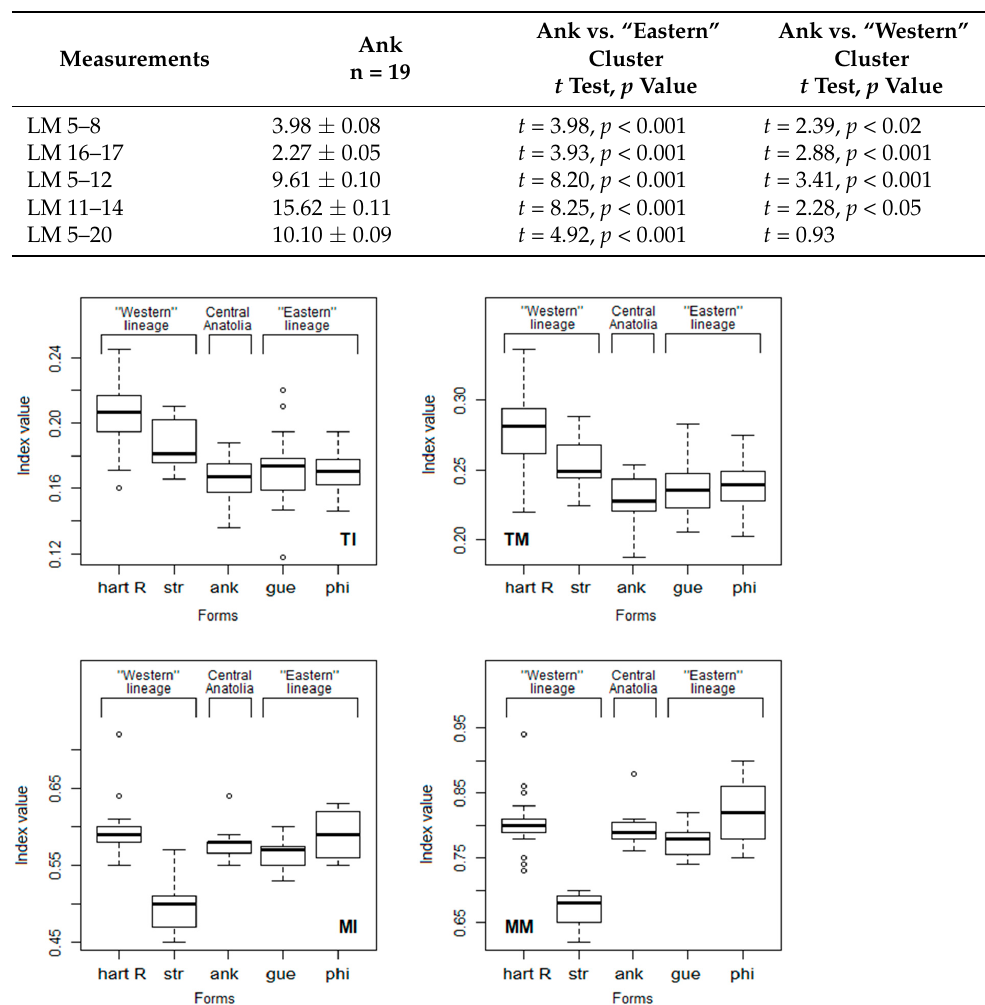
Figure 2. Differences in the morpho-ecological indices of the mandible among social voles in the “guentheri” group. The boxplot bars represent an interquartile range (25th to 75th percentiles) and white dots are outlier data points that are located outside 1.5 times the interquartile range above the upper quartile and below the lower quartile: TI: temporal incisor index, TM: temporal molar index, MI: masseter incisor index; MM: masseter molar index.